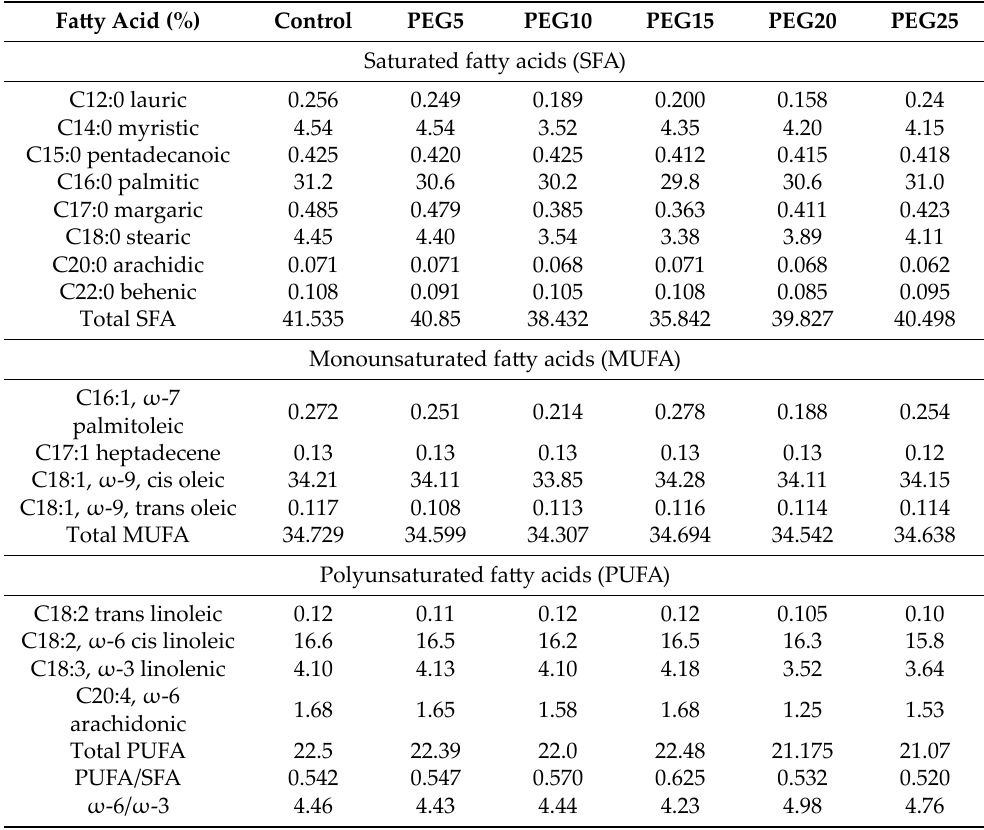
Table 3. Semi‑smoked sausages with varying emulsion gel concentrations (g/100 g product) in terms of fatty acid